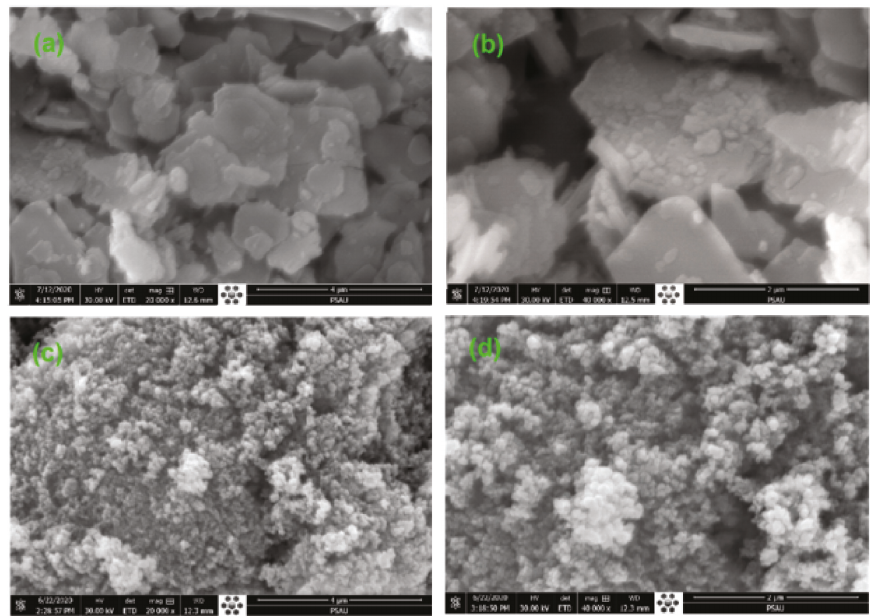
Figure 2: Undoped and Cu-doped ZnO FE-SEM micrographs: (a) low and (b) high magnifications of pure ZnO and (c) low and (d) high magnifications of Cu-doped ZnO